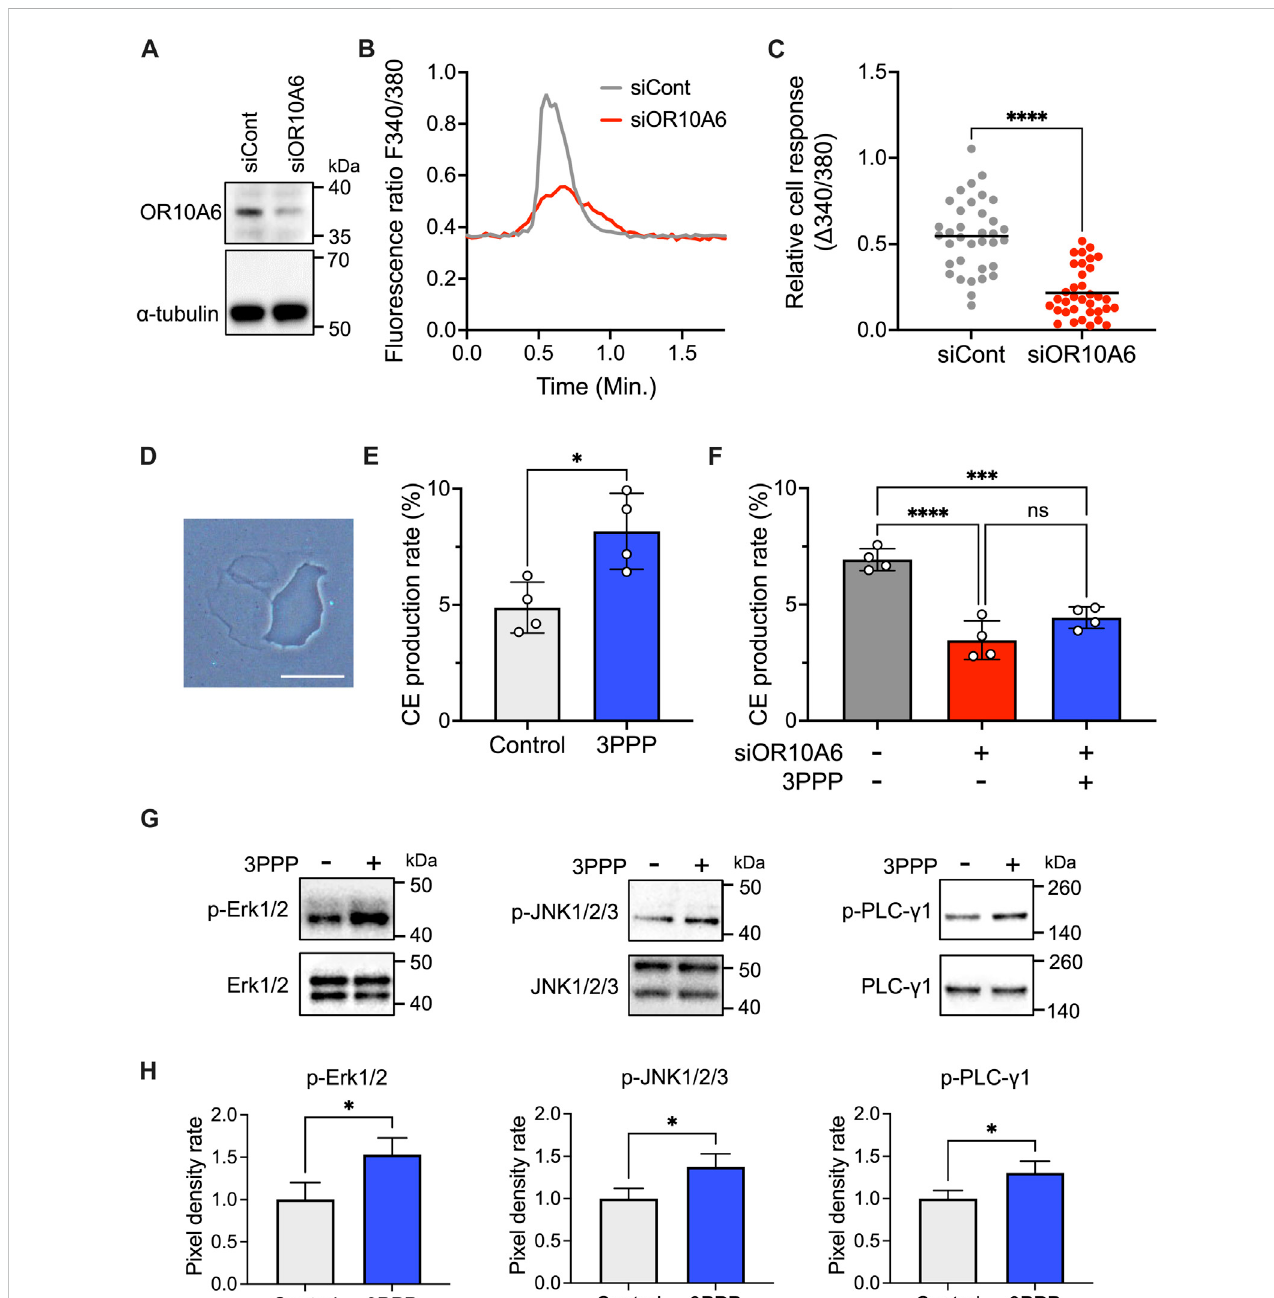
FIGURE 5 Calciumresponse,CEproductionandphosphokinaseanalysisinducedby3PPPinkeratinocytestreatedwithOR10A6siRNA. (A) Westernblotanalysisfor thedetectionofOR10A6incellstreatedwithscrambleRNAorOR10A6siRNA. (B) Representativepro fi lesofintracellularcalciumafter3PPP(1 mM)application to cells treated with scramble RNA or OR10A6 siRNA. (C) Quantitation of fl uorescence ratio change after application of 3PPP (1 mM) to cells treated with scramble RNA or OR10A6 siRNA (n = 35 cells). (D) Representative image of produced CE. Bar = 50 μ m. (E) CE production rate of keratinocytes treated with3PPP(1 mM)( n =4). (F) CEproductionrateofkeratinocytestreatedwithscrambleRNAorOR10A6siRNAand3PPP(1 mM).AnovaFvalue=33.63and p < 0.0001( n =4).Similarresultswereobtainedinthreeindependentexperiments. (G) WesternblotanalysisforthedetectionofphosphorylationofJNK1/2/3and PLC- γ 1incellstreatedwith3PPP(1 mM). (H) Quantitationofwesternblotsignal( n =3).Barsandlinesrepresentmean±SD.*: p < 0.05,***: p < 0.001,****: p <